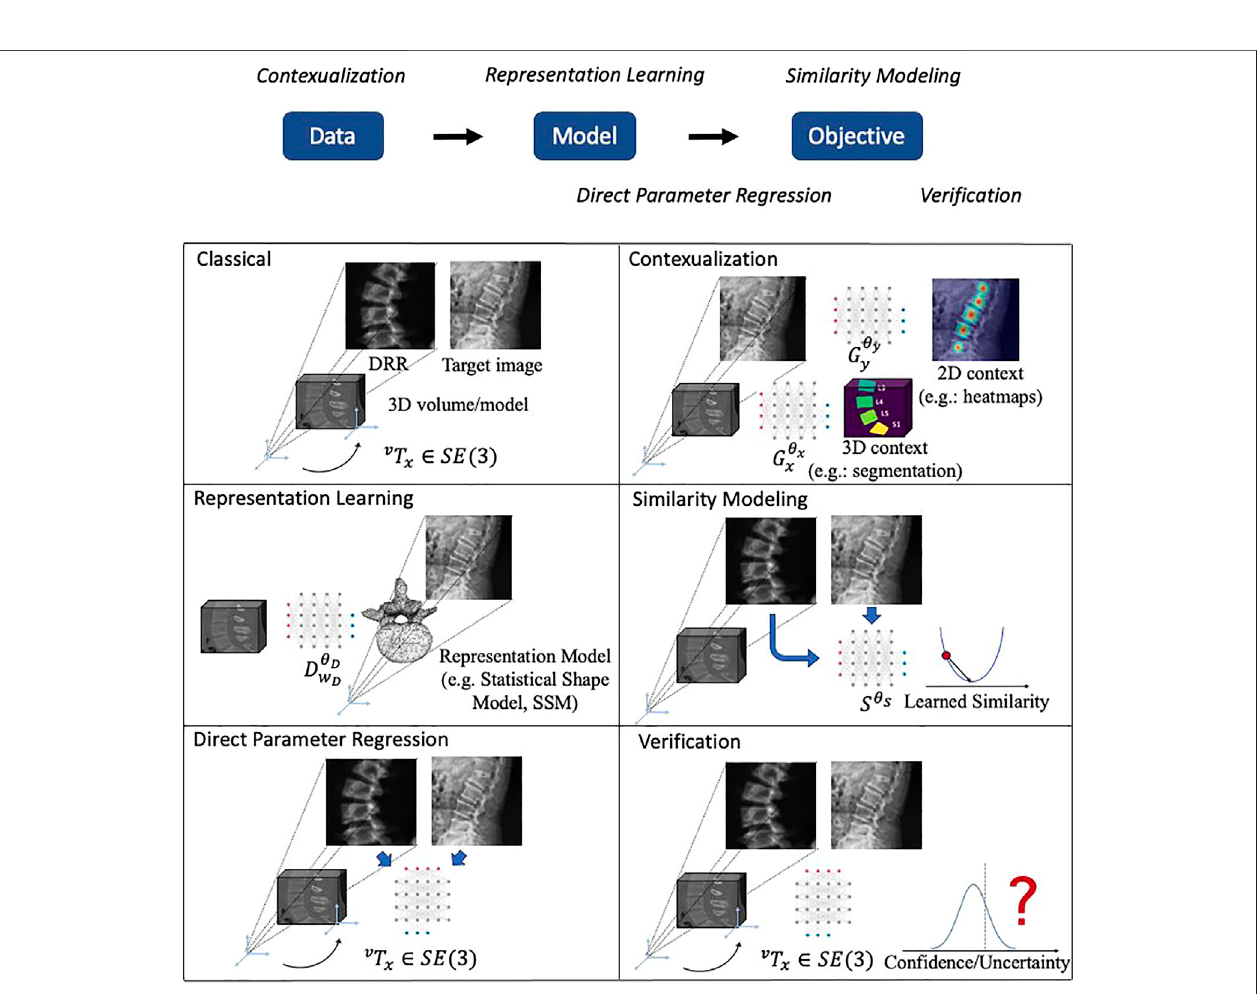
FIGURE3| Illustrationsofthemainthemesofmachinelearningin2D/3Dregistration.Thelogicrelationshipsofthesethemesareshownontop.WeuseaspineCT volume and a spine X-ray image as an example to show the generic 2D/3D projection geometry. Machine learning models are represented with a neural network icon. Key labels and parameters are presented and map to Eqs. 1 , 2 .